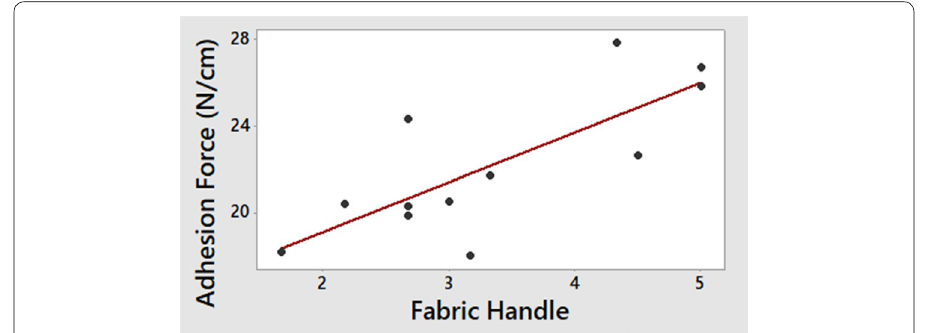
Fig. 10 Effect of fabric handle on adhesion